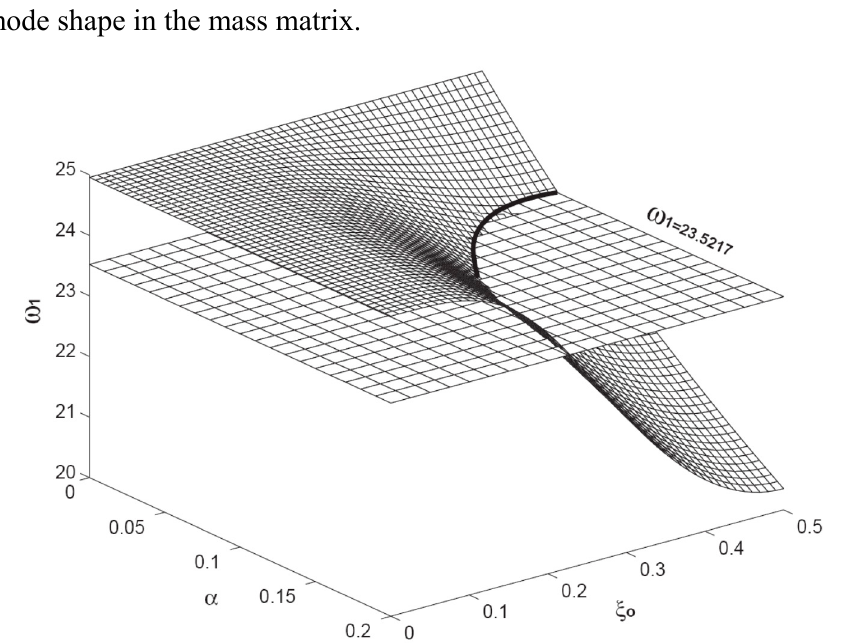
Figure 4. The variation of the first resonant frequency ( level plane is the one with the constant of is marked with a solid curve. Here, the axial load is fixed as β =